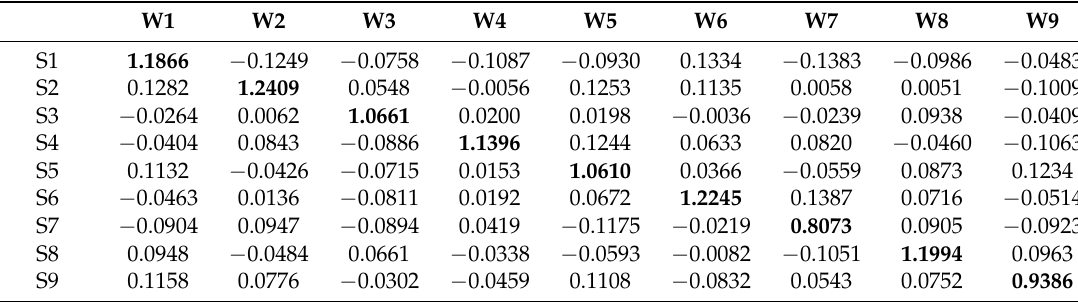
Table 3. Average Classification Label for Various Types of Voltage Sag Sources.